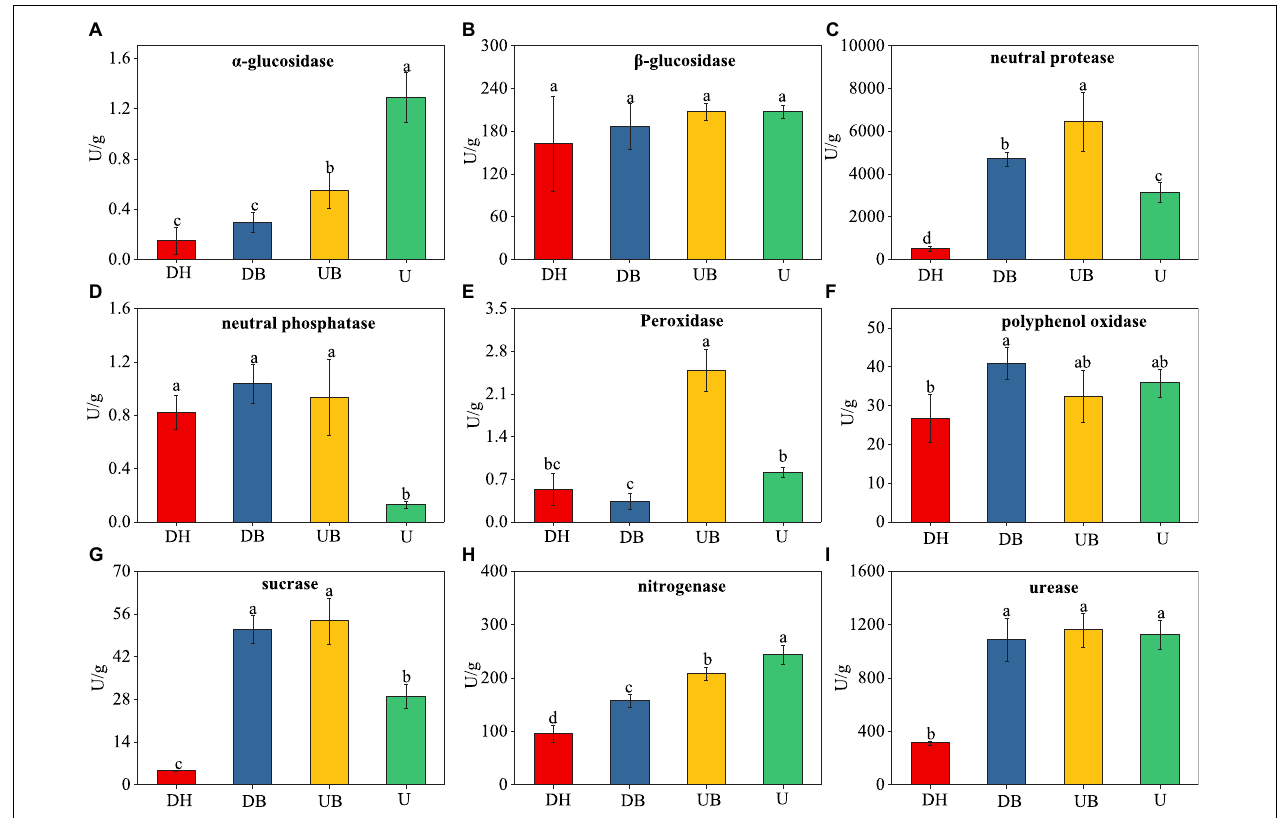
FIGURE 2 | Changes in the enzyme activity of the biocrusts under different disturbance levels ( n = 3). (A) α -glucosidase. (B) β -glucosidase. (C) neutral protease. (D) neutral phosphatase. (E) peroxidase. (F) polyphenol oxidase. (G) sucrase. (H) nitrogenase. (I) urease. Significant differences ( P < 0.05) are marked by different letters.